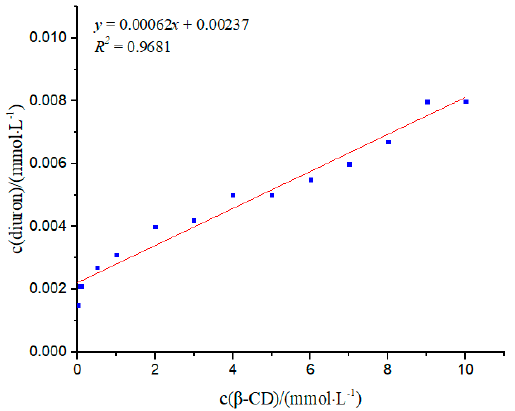
Figure 6. Phase solubility study of the inclusion complex.